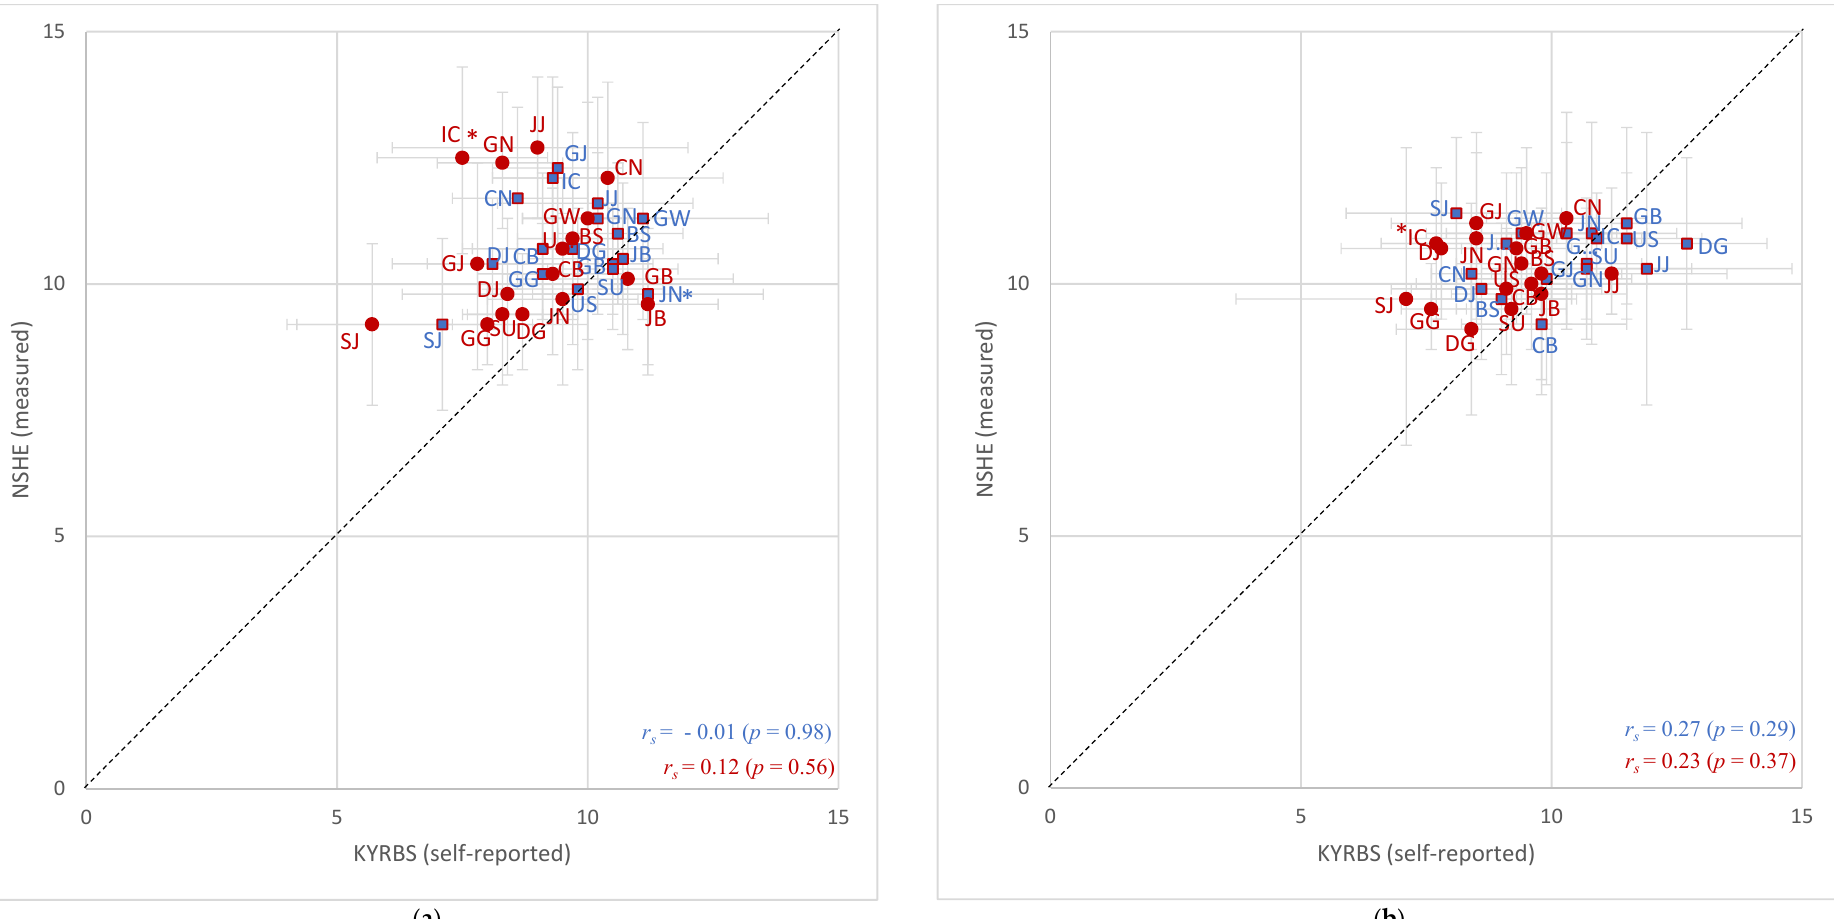
Figure 4. Simple correlation graphs for regional overweight prevalence estimated from the KYRBS (self-reported) and NSHE (directly measured). ( a ) Comparisons of 2018 prevalence between the data sources; ( b ) comparisons of 2019 prevalence between the data sources. Dots represent weighted percentage and gray lines indicate 95% confidence intervals. Values for boys are presented with blue (square) dots and those for girls are presented with red (circle) dots. Regions with prominent ranking discrepancies are marked with asterisk(s) and